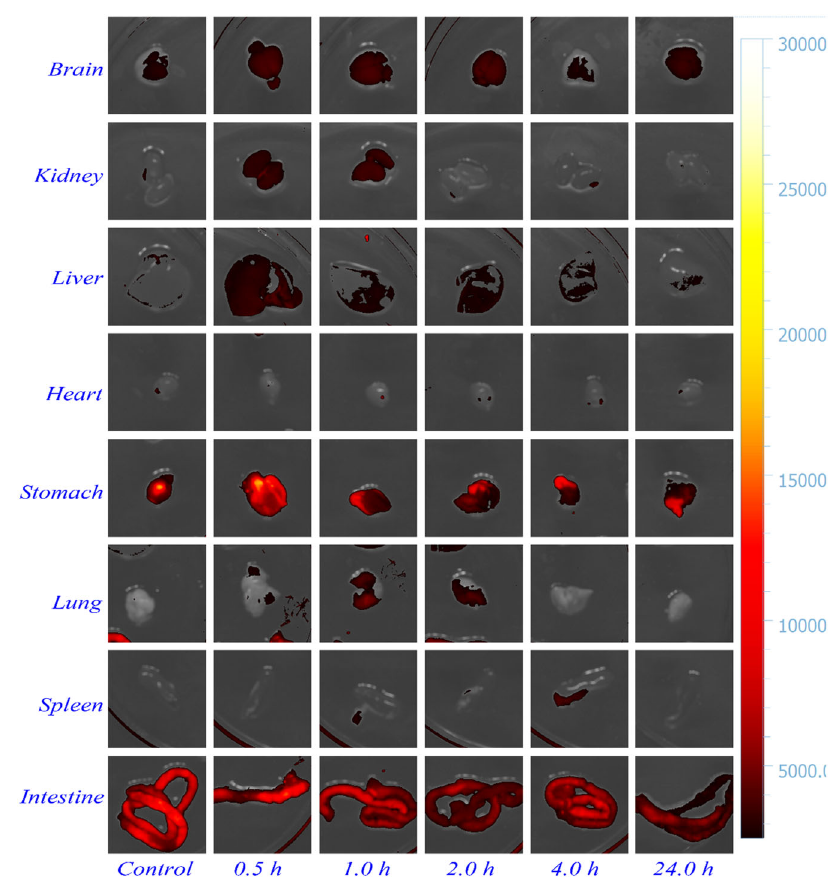
Fig. 4 Real-time ex vivo imaging of mice with intravenous injection of the BCQD@Mn composite at different time points ( n =